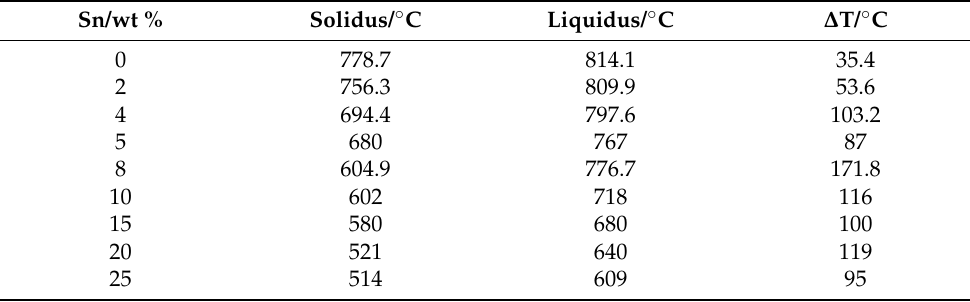
Table 1. Melting characteristics of Ag60Cu filler metals with different contents of Sn